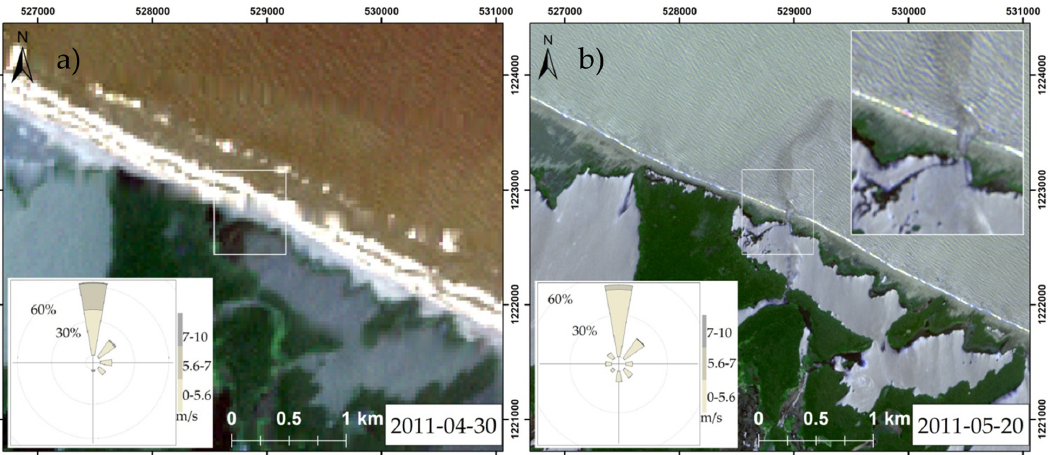
Figure 8. Breaching process for Las Piedras lagoon in May 2011: ( a ) Last image with no breach taken on 30 April 2011. ( b ) The first image with the breach and sediment plume was taken on 20 May 2011. Wind roses indicate wind conditions two weeks prior to image acquisition. Rapideye imagery courtesy of Planet Labs.